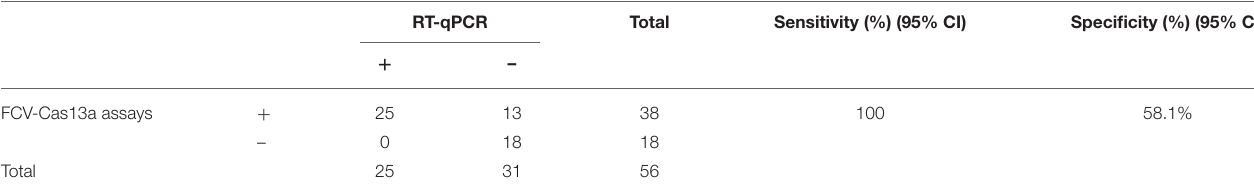
TABLE 1 | Comparison between FCV-Cas13a assays and RT-qPCR method used for detecting 56 clinical